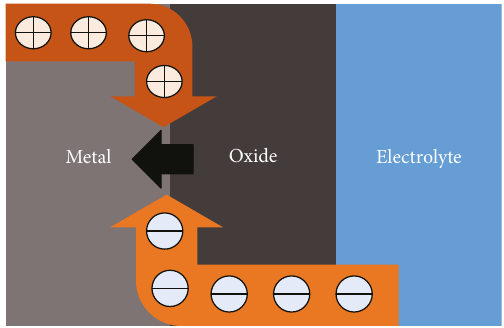
3: Scheme of ion transport during high- fi eld